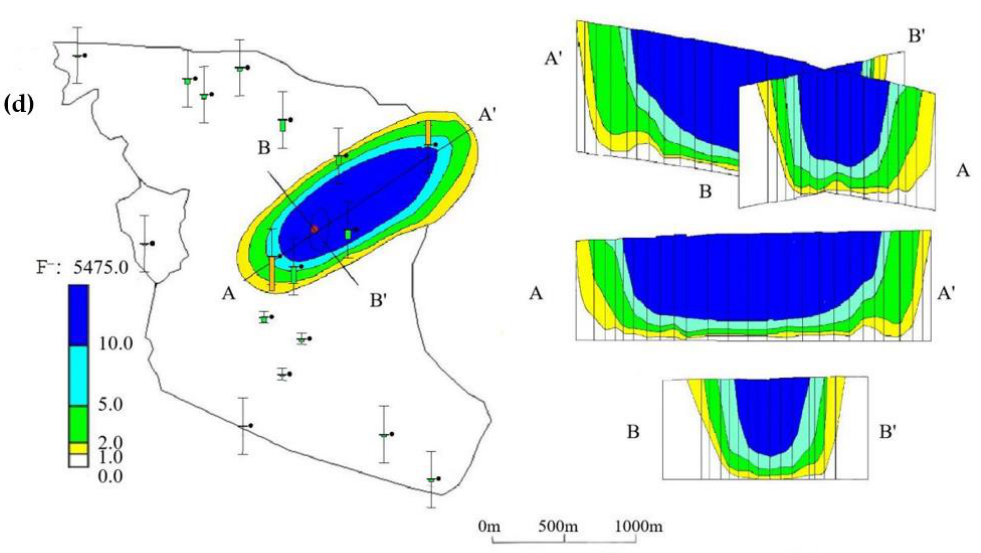
Figure 9. Distribution of pollution plumes in different pollution situations: ( a ) one year later, ( b ) five years later, ( c ) ten years later and ( d ) fifteen years later.